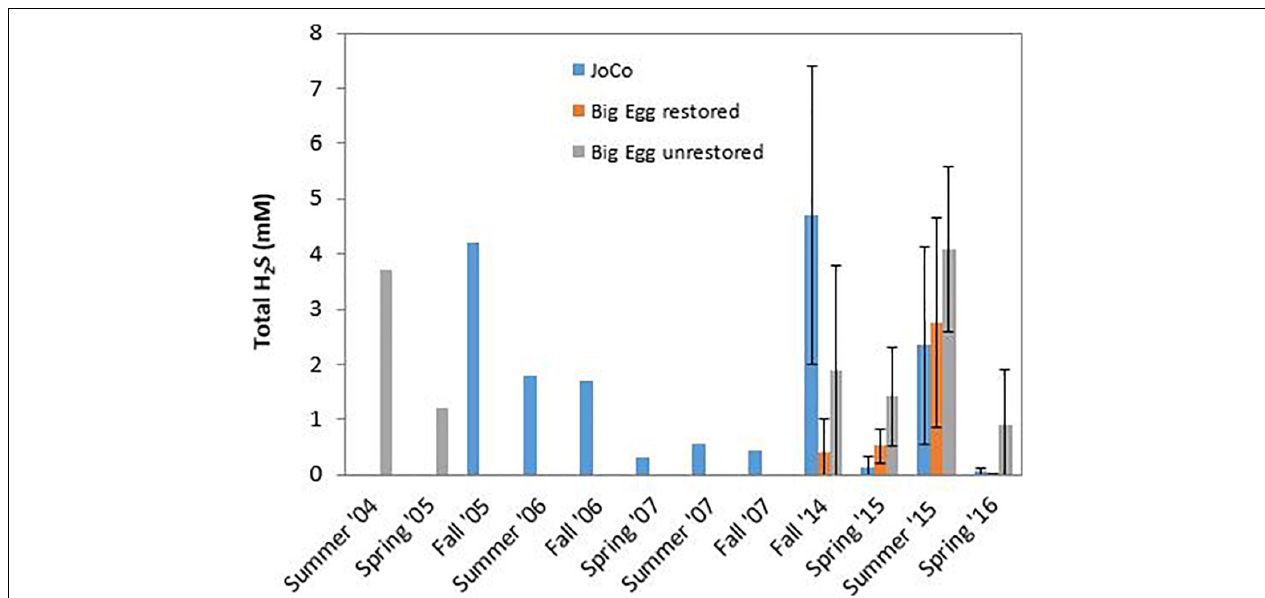
FIGURE 9 | Temporal variation of average total dissolved inorganic sulfide ( (cid:54) H 2 S) in pore water of JoCo and Big Egg salt marsh at Jamaica Bay. BE1 is the restored marsh, BE2 and BE3 are the unrestored marsh. Data were averaged from (cid:54) H 2 S concentrations measured on samples taken at 4–5 discrete depths from 5 to 30 cm. Vertical lines demote 1 σ uncertainties of the mean of several sites sampled in each marsh from 2014 to 2016.